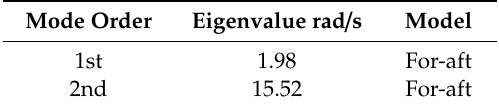
Table 4. Structural dynamic properties in modal analysis.